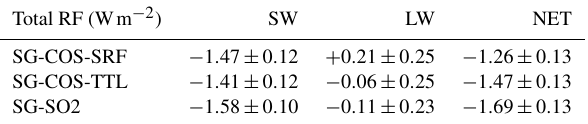
Table 6. Globally and annually averaged total RF of sulfate aerosols and greenhouse gases for the SG experiments with respect to BG (shortwave, longwave, and net; Wm − 2 ; years 2046–2055).